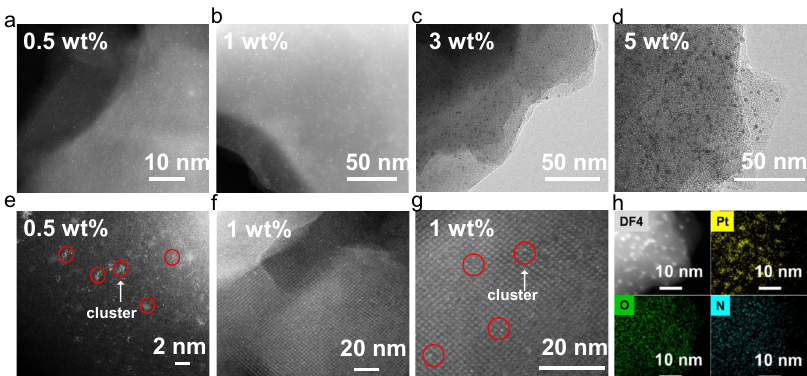
Fig. 5 Morphologies of PY-DHBD-COF and platinum cocatalyst. HR-TEM and HAADF-STEM images of PY-DHBD-COF loaded a , e 0.5wt% Pt. b , f , g 1wt% Pt. c 3wt% Pt and d 5wt% Pt. h EDX mapping images of 1wt% Pt